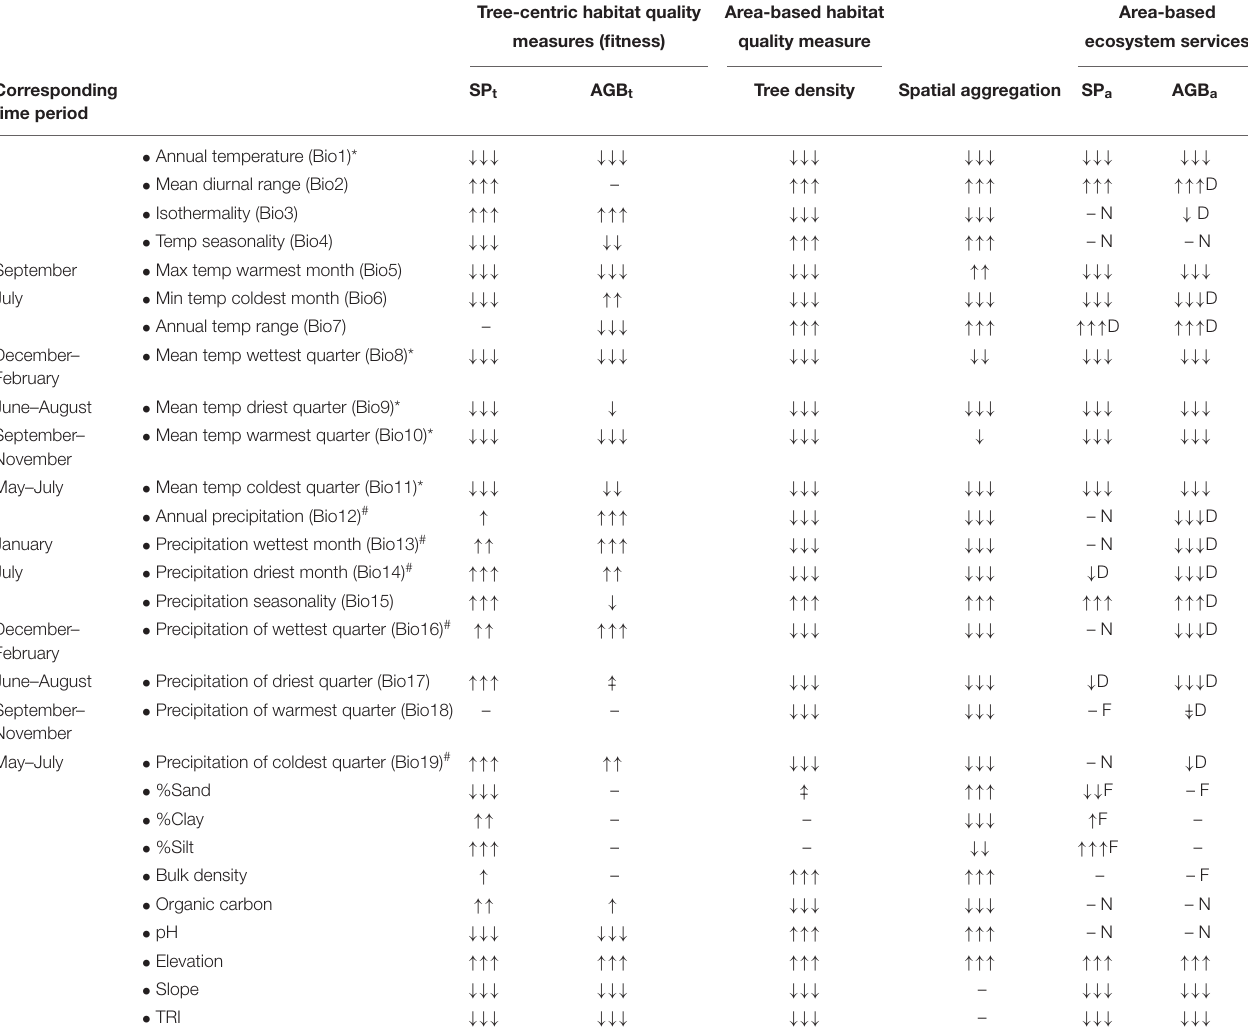
TABLE 2 | Relations between environmental variables and Brazil nut tree fitness variables, densities and spatial aggregation, and tree- and area-based AGB and estimated seed production. Tree-centric habitat quality Area-based habitat